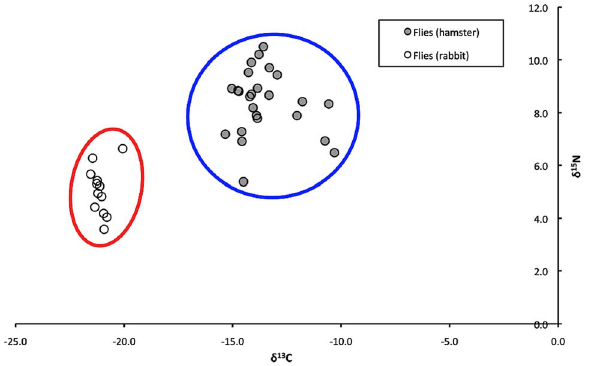
Figure 1. Stable carbon and nitrogen isotope ratios ( d 13 C and d 15 N) of individual adult sand flies that had been reared in the laboratory on the feces of either hamsters or rabbits. Hierarchical cluster analysis identified 3 significantly different groups of samples based on d 13 C and d 15 N values. The cluster circled in red contained all sand flies reared as larvae on rabbit feces, and the cluster circled in blue contained all sand flies reared as larvae on hamster feces.